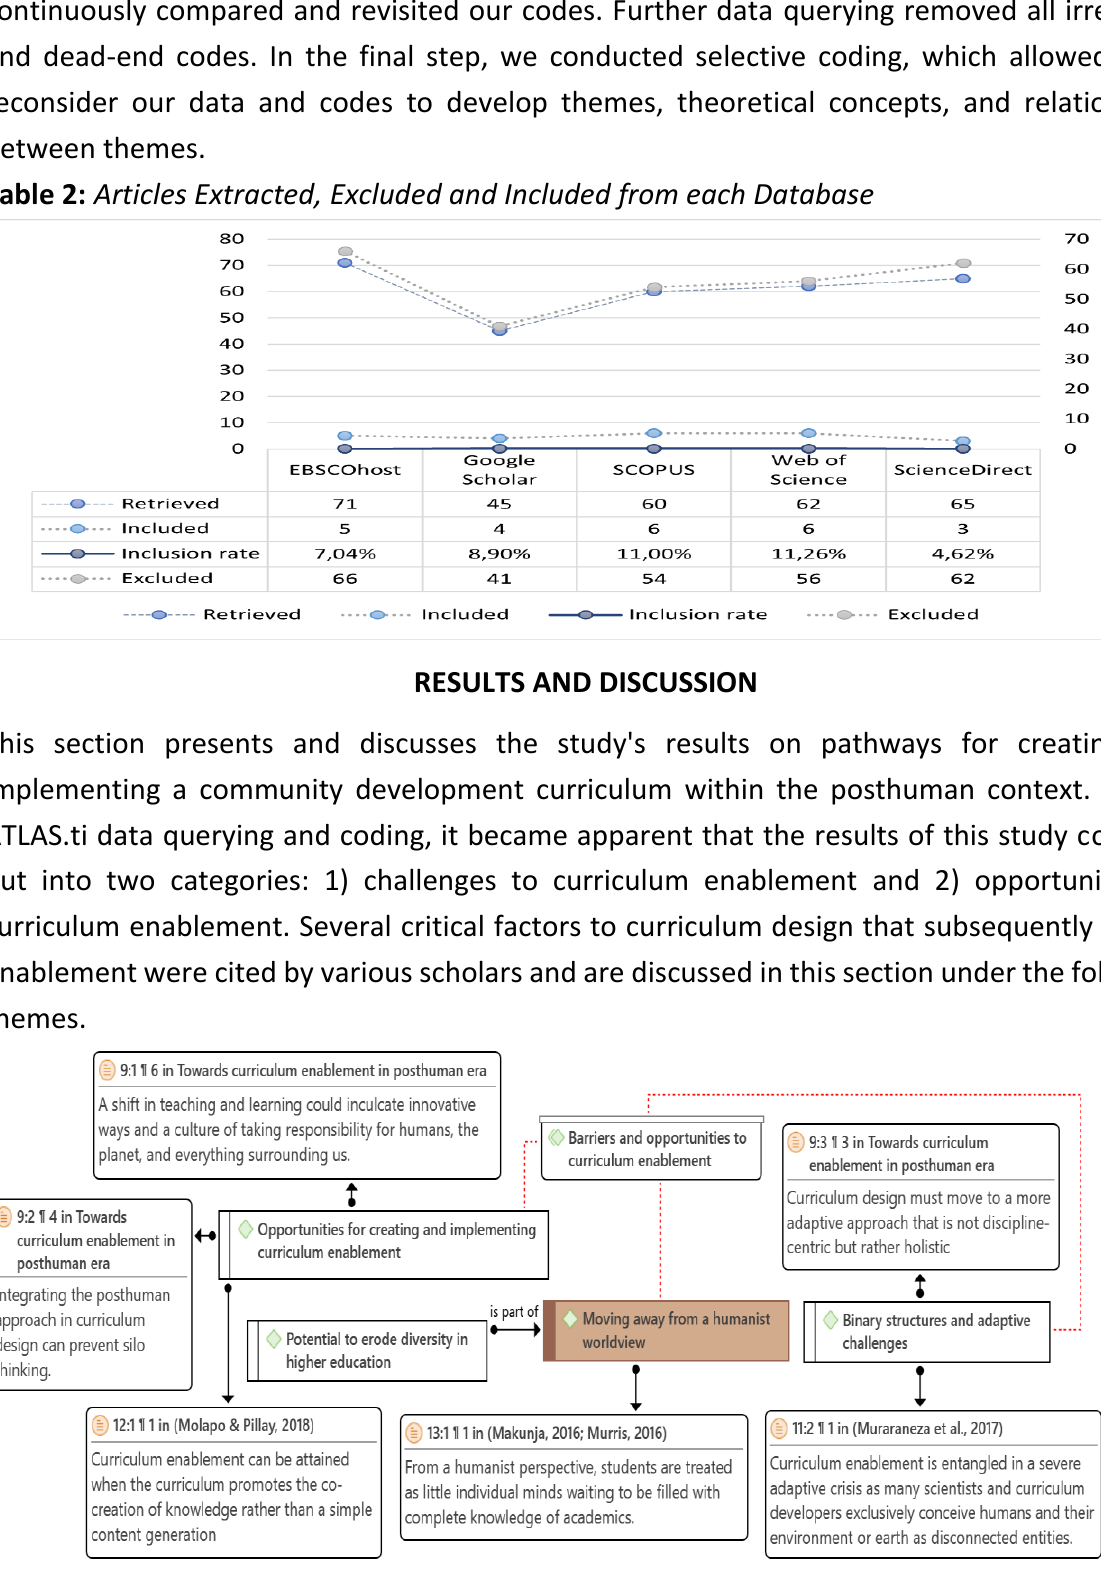
Figure 1: Challenges and opportunities to curriculum enablement as reviewed from literature